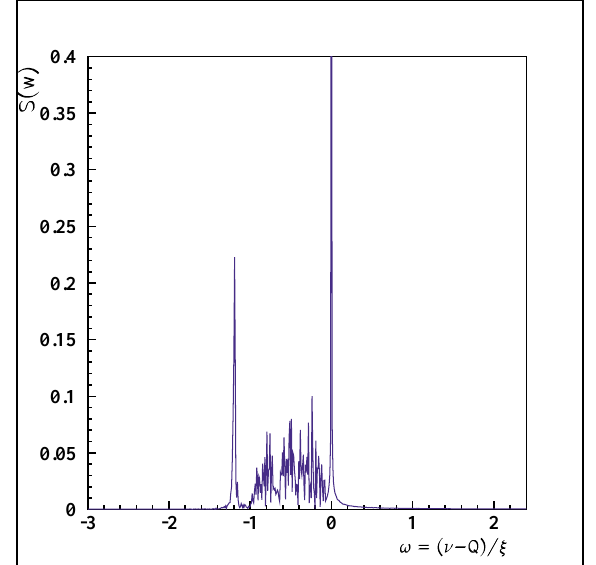
FIG. 7. (Color) Frequency spectrum of the bunch centroid mo- tion (for 2 17 turns, N (cid:1) 10 4 macroparticles) for round beams and size ratios s (cid:2) 2 (cid:3) (cid:5) s (cid:2) 1 (cid:3) (cid:1) 0.70 and intensity ratio R I (cid:1) 0.5